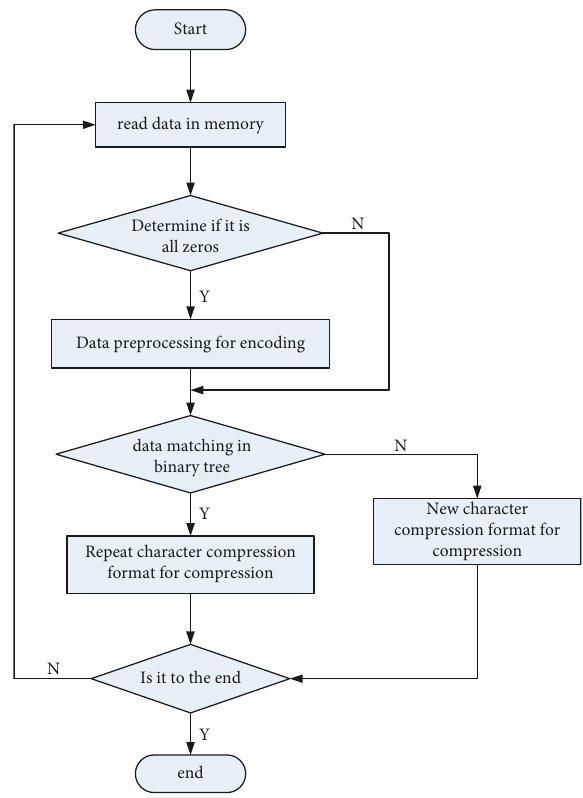
Figure 5: Flowchart of compression process of LZSS-based memory data efficient compression algorithm. Table 3:1995–2014 China’s total exports as a proportion of China’s